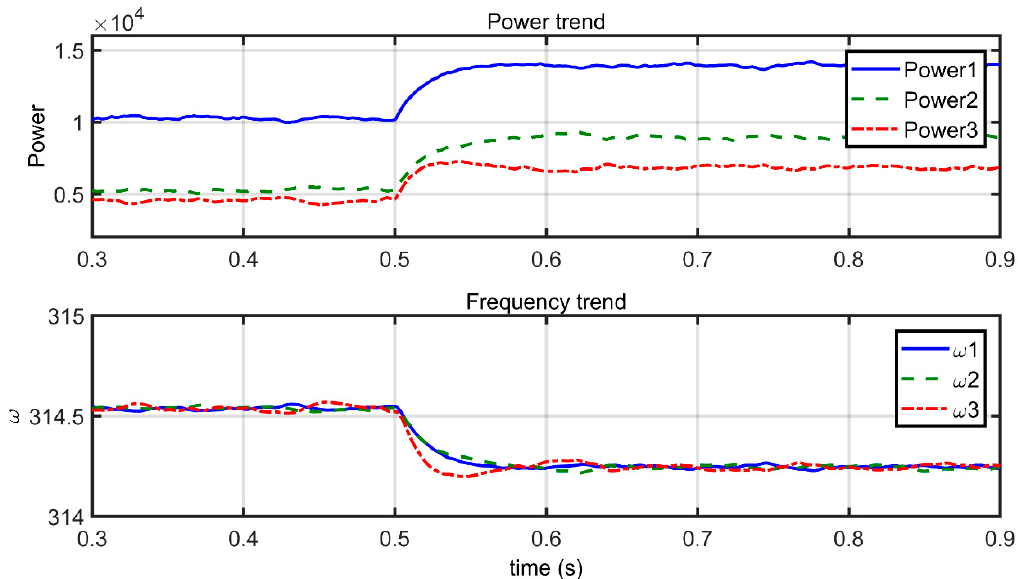
Figure 12. Power and Frequency Trend Case II.